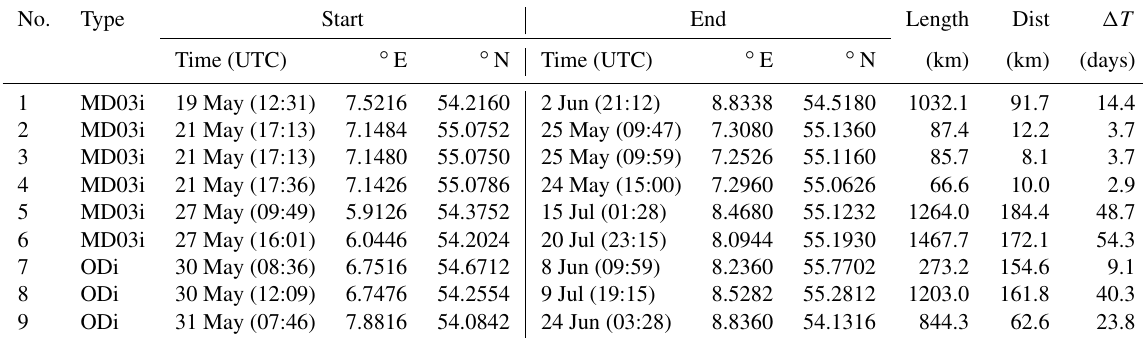
Table 1. Drifters deployed in May 2015.